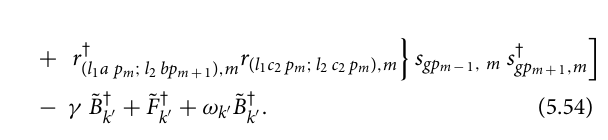
FIGURE 9 | Damped temporal curves showing the overlay of the real (gray) and imaginary (red) parts of the operators B † p which are consecutively outlined through steps 1–4. The algebraic